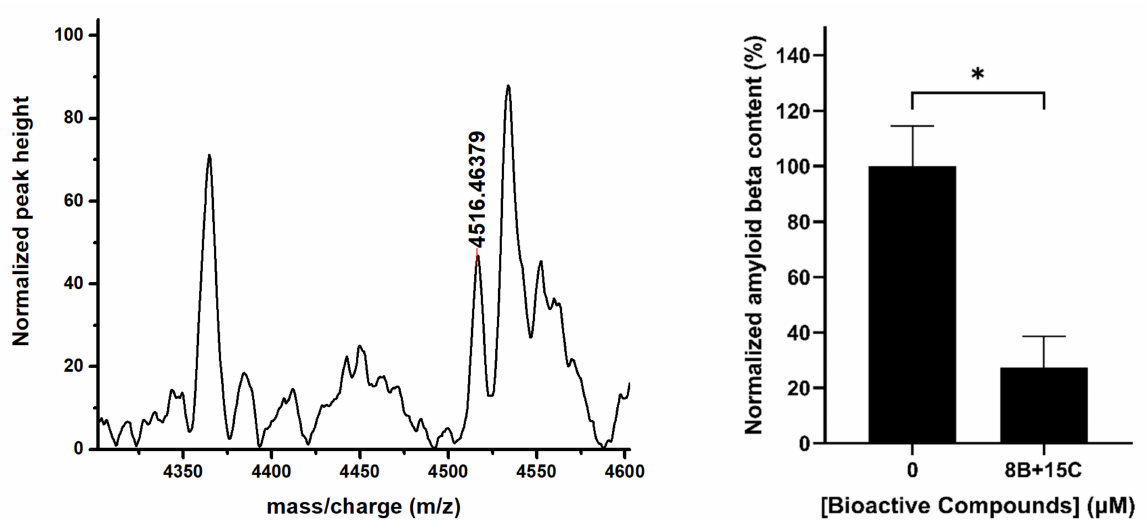
Figure 7. Quantification of intracellular A β 42 in BY4743 [pYEX.A β ] cells treated with trans -chalcone and baicalein. Left panel showing mass spectrum of cell lysate protein peaks near the expected molecular weight (4516 Da) of A β 42 obtained from MALDI-TOF MS. Right panel shows levels of A β 42 protein in BY4743 [pYEX.A β ] cells treated with the combination of 8 µ M baicalein and 15 µ M trans -chalcone (8B + 15C). Statistically significant values obtained from unpaired t-test for difference in mean are represented by asterisks (* p <